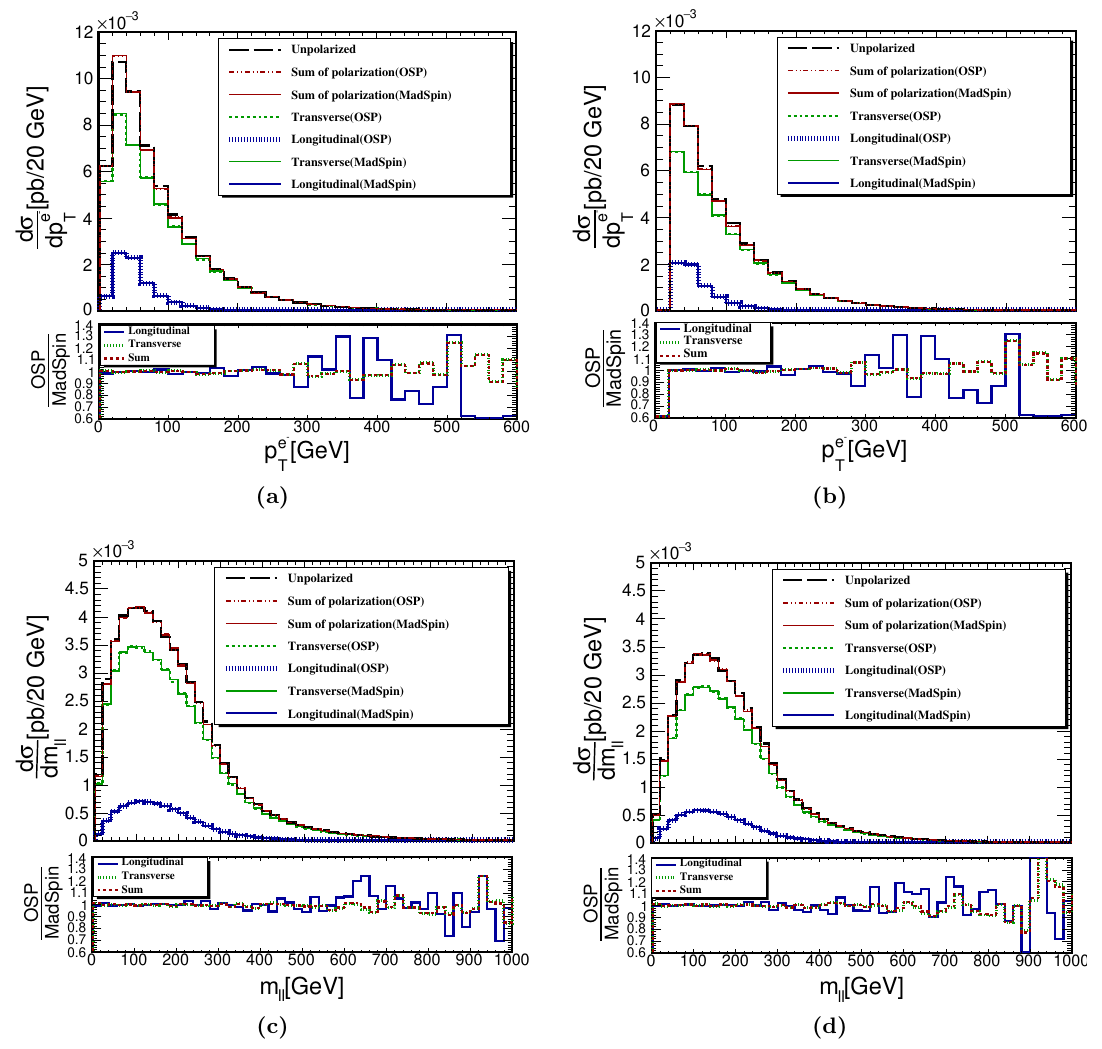
Figure 8. Same as (cid:12)gure 4 but for the mixed EW-QCD process pp ! jjW + W (cid:0)